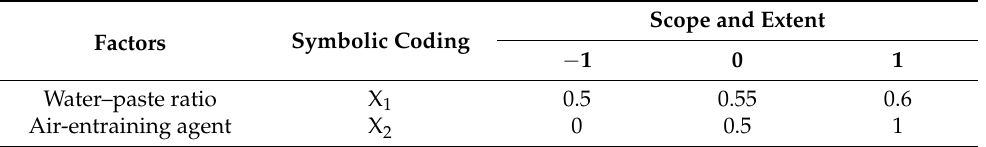
Table 3. Central composite response surface factor-level